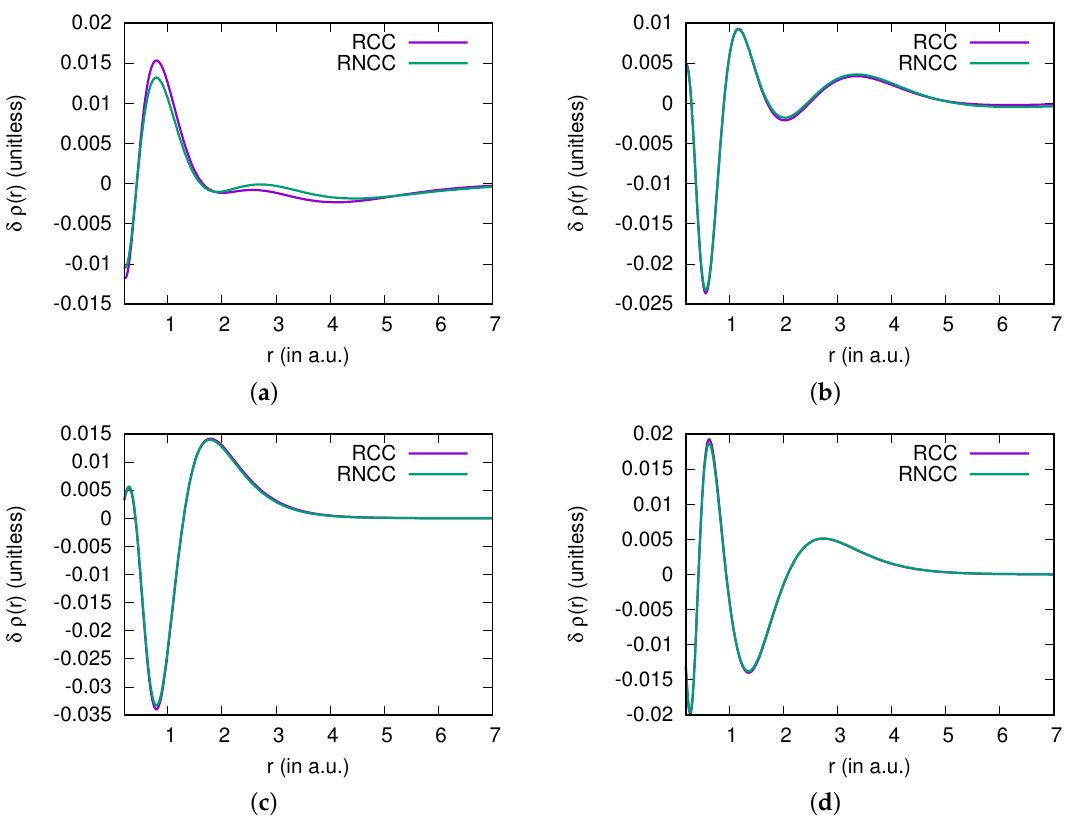
Figure 2. Correlation contributions to ρ ( r ) (shown in figure as δρ ( r ) ) from the RCC and RNCC methods in ( a ) Be, ( b ) Mg, ( c ) Ne and ( d ) Ar. As seen, the δρ ( r ) values are almost the same through the RCC and RNCC methods in all atoms except Be in which slight differences are